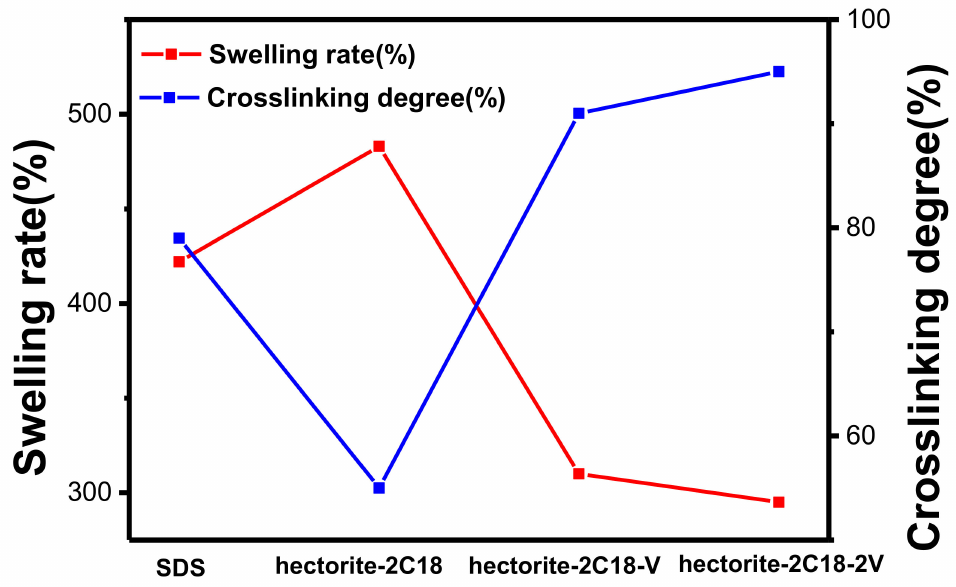
Figure 7. Swelling ratio and crosslinking degree of the cured films from the polyacrylate latex coatings prepared with SDS (1 wt%), Laponte-2C18 (3 wt%), hectorite-2C18-V (3 wt%), hectorite-2C18-2V (3